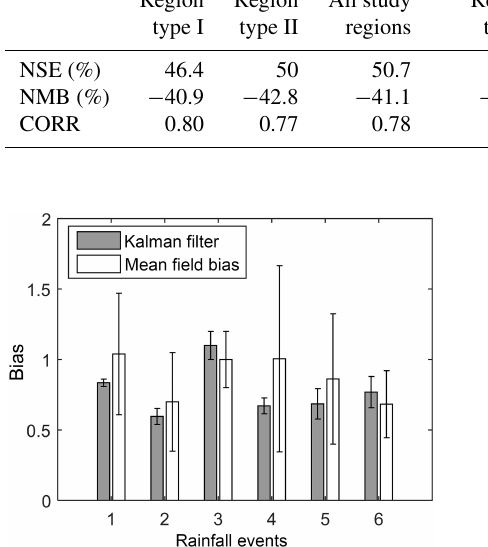
Figure 9. The average and covariance of bias estimation by Kalman filter and mean field bias method for six rainfall events.